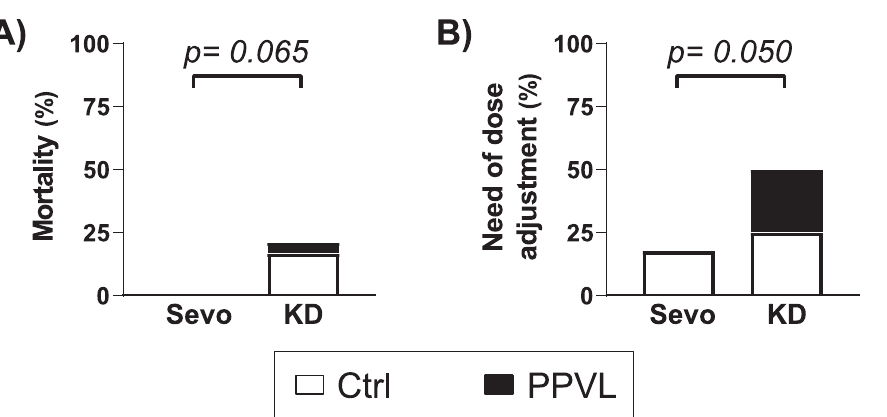
Fig 2. A) Mortality (%) and B) proportion of rats requiring adjustment of the dose in normal rats (Ctrl, white bar portion) and rats with partial portal vein ligation (PPVL, black bar portion) anesthetized with sevoflurane (Sevo) or with ketamine+diazepam (KD). Comparisons were performed with Fisher’s exact test.